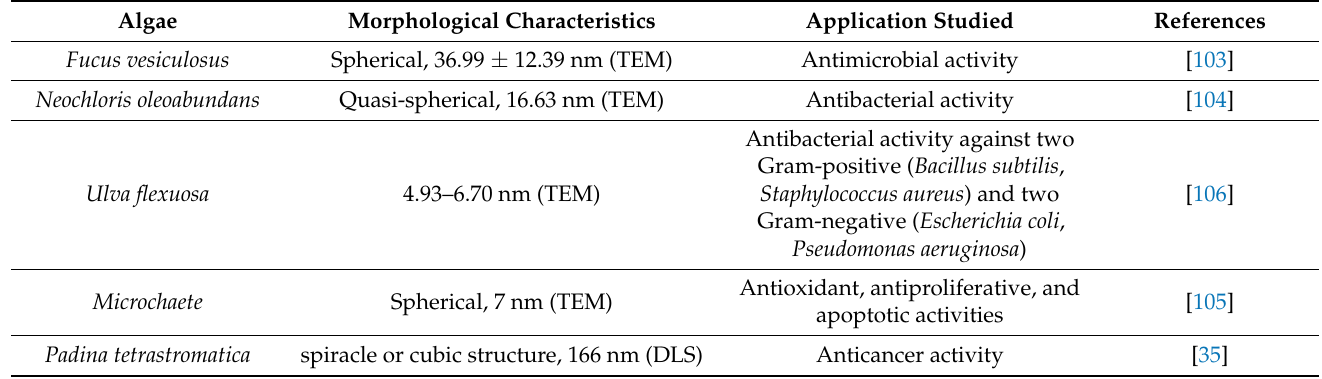
Table 5. Algae-mediated synthesis of AgNPs, their morphological characteristics, and their